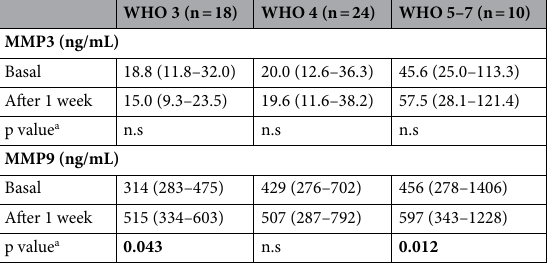
Table 5. Comparison of serum MMPs in COVID-19 patients at hospital admission and after 1 week. Median and interquartile range. a Wilcoxon signed-rank test. Significant values are reported in bold. n.s . not